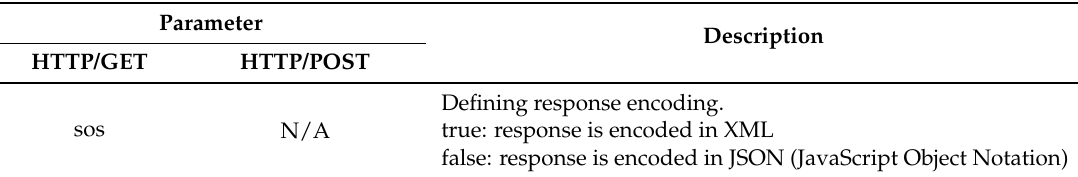
Table 3. Request parameter of the getCapabilities